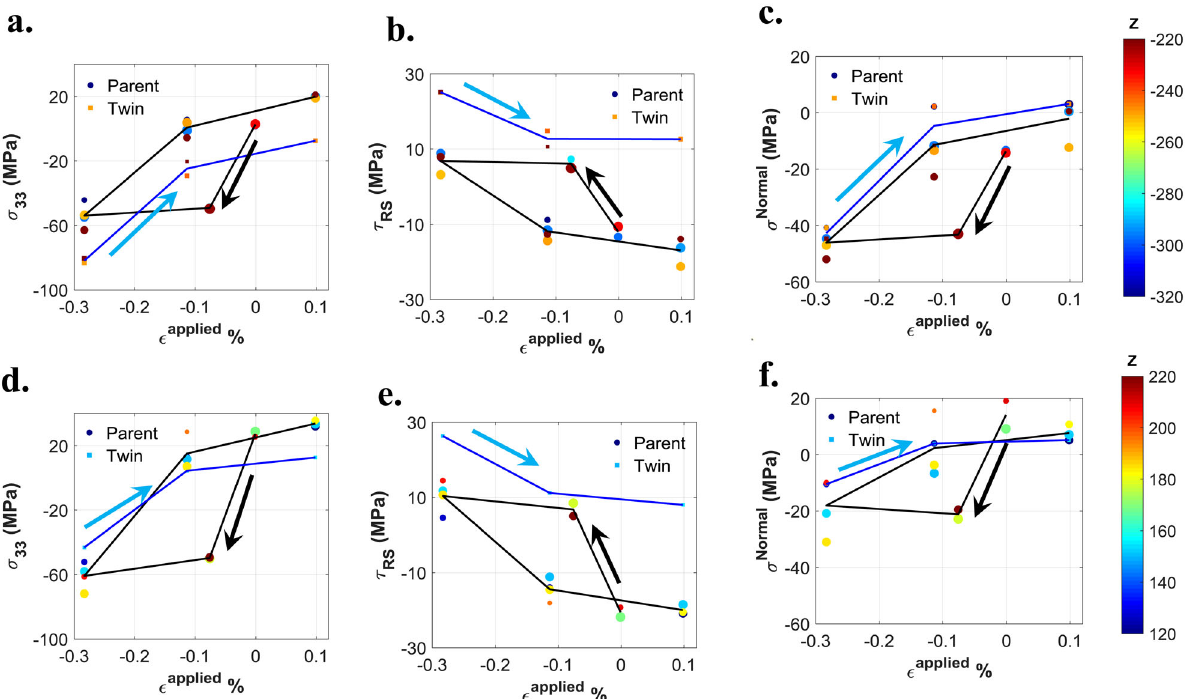
Fig. 4 Stress variation within twin-parent pairs. The evolution of σ 33 , the shear stress in twinning direction, and the normal stress acting on twin habit plane for ( a - c ) the fi rst twin-parent pair and ( d - f ) the second pair. Parent grains are shown with circles, twins with squares, and each marker represent a portion of the grain measured with 3D-XRD. Markers are colour coded with respect to their measured position along the loading direction (Z) and arrows show the sequence of